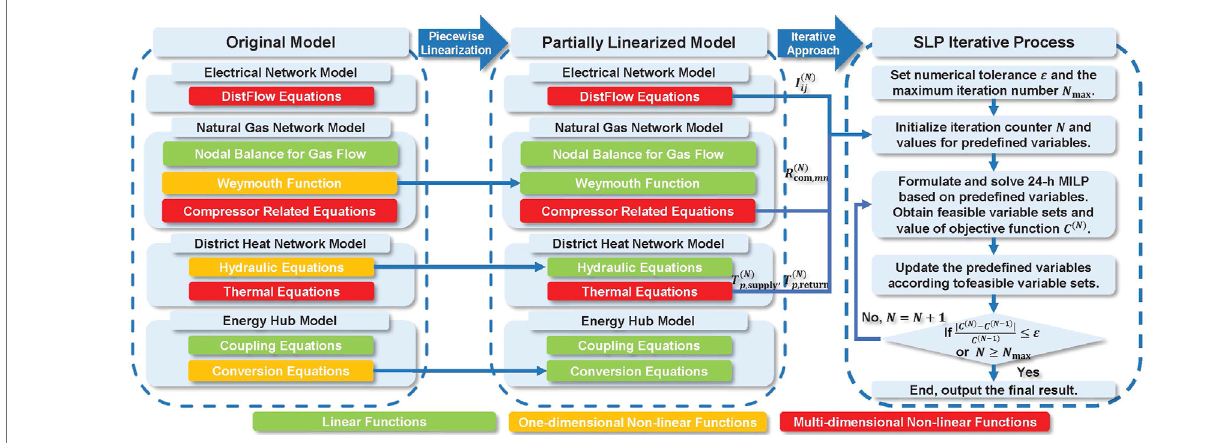
FIGURE 4 | Framework of the linearization process and iteration approach.